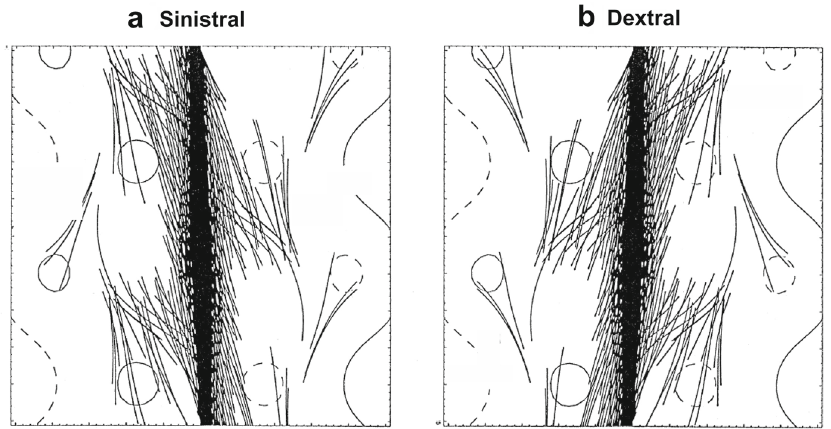
Fig. 8 Adding parasitic polarities to the photospheric flux distribution results in a linear-force-free flux rope with filament barbs. Dark lines represent dips in magnetic field lines consistent with a left-handed (sinistral) and b right-handed (dextral) chirality barbs. Image reproduced with permission from Aulanier and Démoulin (1998), copyright by ESO; see also Aulanier et al. (1998)